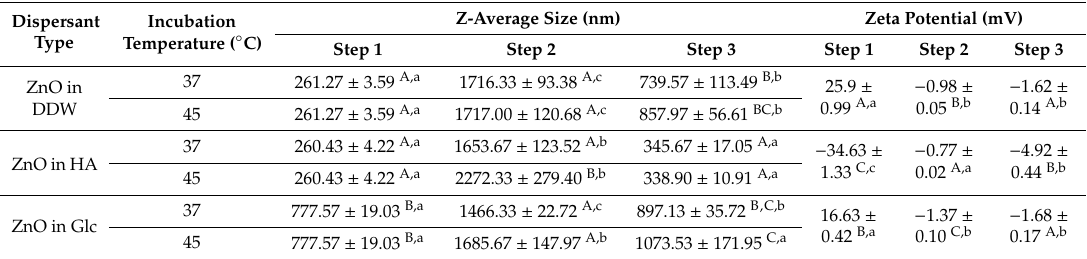
Table 1. Hydrodynamic radii and zeta potentials of pristine ZnO nanoparticles (NPs) in different CPE conditions.